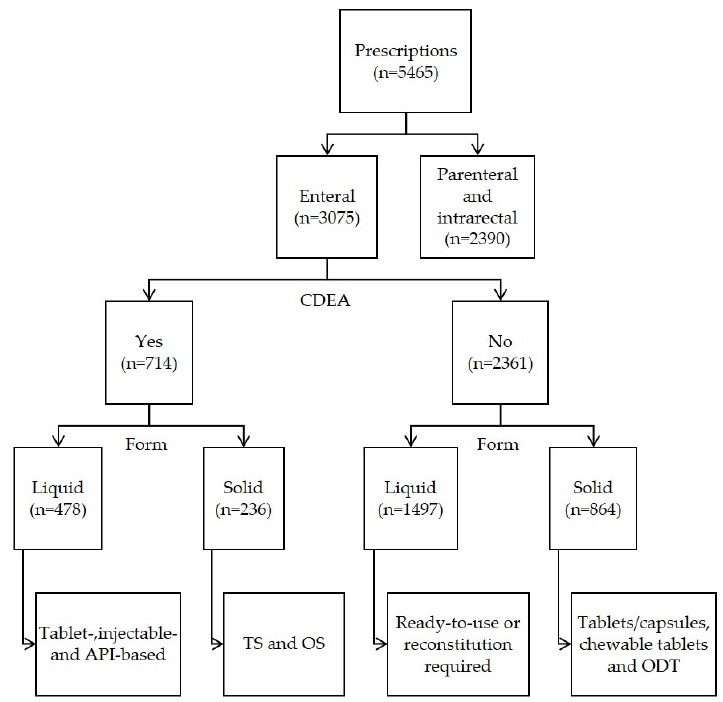
Abbreviations: API, active pharmaceutical ingredient; CDEA, compounded drug for enteral admin ‐ istration. 1 Percentage represents the proportion of prescriptions on total active prescriptions for the